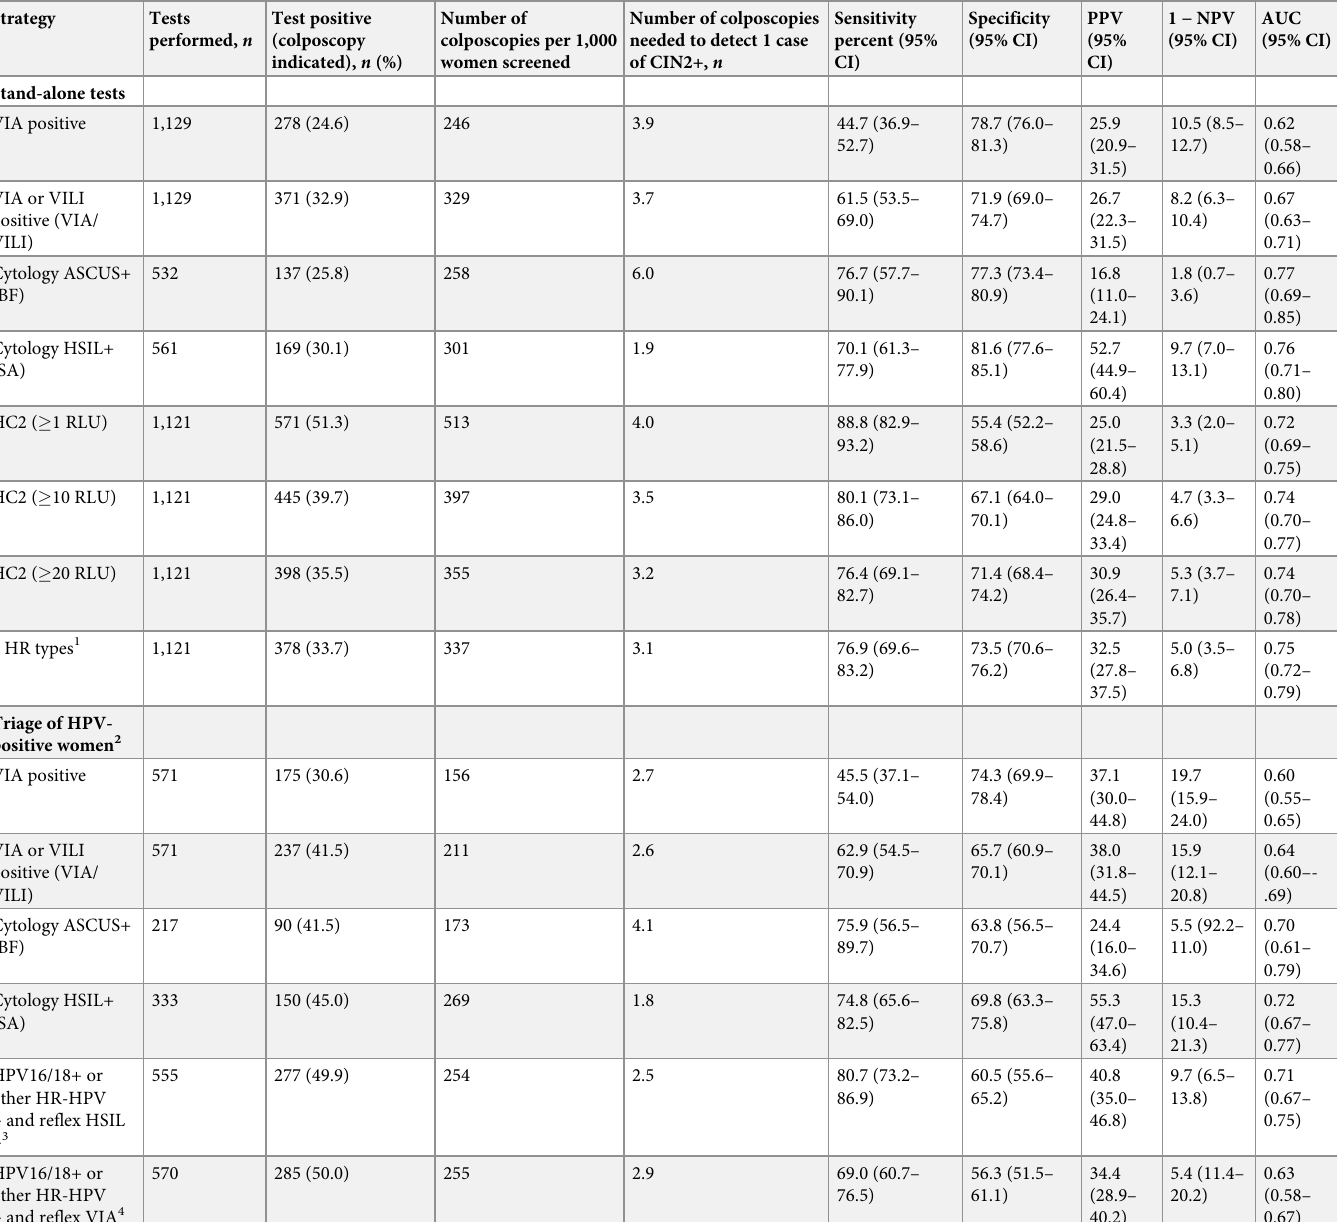
Table 2. Performance of screening strategies for detection of prevalent CIN2+ among 1,130 women living with HIV (554 in BF; 576 in SA).